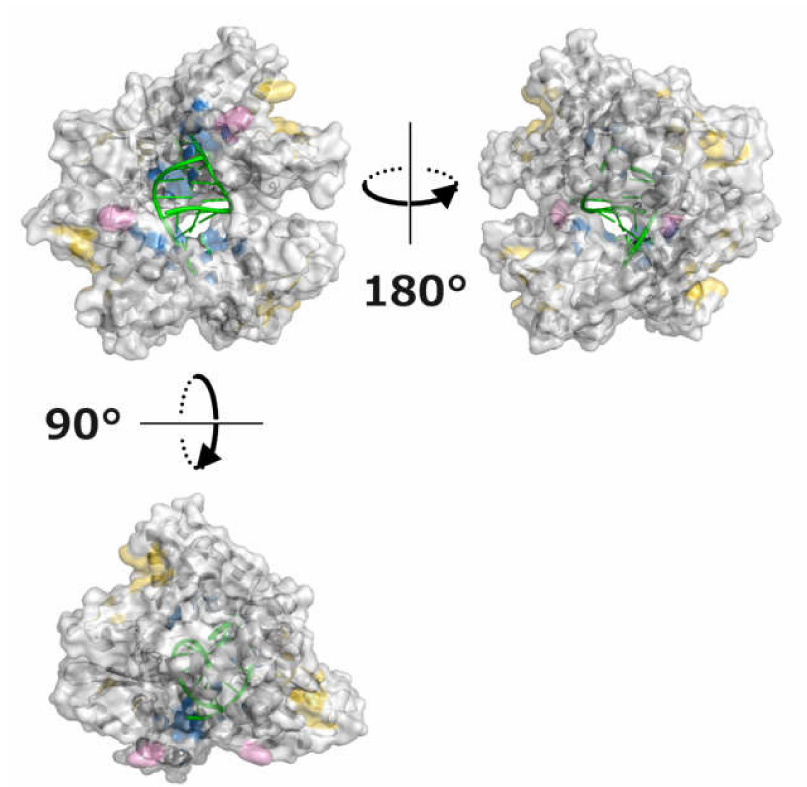
Figure 5. Structure of the VP35 IID-dsRNA complex. Three-dimensional structures of the VP35 IID tetramer complexed with dsRNA are shown (PDB ID: 3L26). The crystallographic asymmetric unit contains four VP35 IID molecules and one 8 base-pair dsRNA (green). Hydrophobic patch regions #1, #2, and #3 are shown in pink, blue, and yellow, respectively.